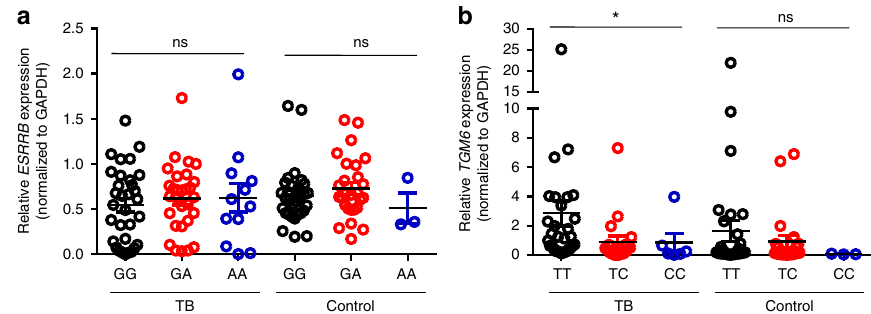
Fig. 2 Association of SNPs with mRNA expression in PBMCs. Genomic DNA and mRNA were isolated from PBMCs from 73 TB patients (TB) and 61 healthy individuals (Control). ESRRB and TGM6 mRNA expression was measured via quantitative RT-PCR and normalized to GAPDH . a The association between ESRRB mRNA expression and rs12437118 genotype. b The association between TGM6 mRNA expression and rs6114027 genotype. Each symbol represents an individual. Data are representative of one independent experiments. Data shown were mean ± SD and statistical signi fi cance was determined via linear regression, ∗ P < 0.05; ns, not signi fi